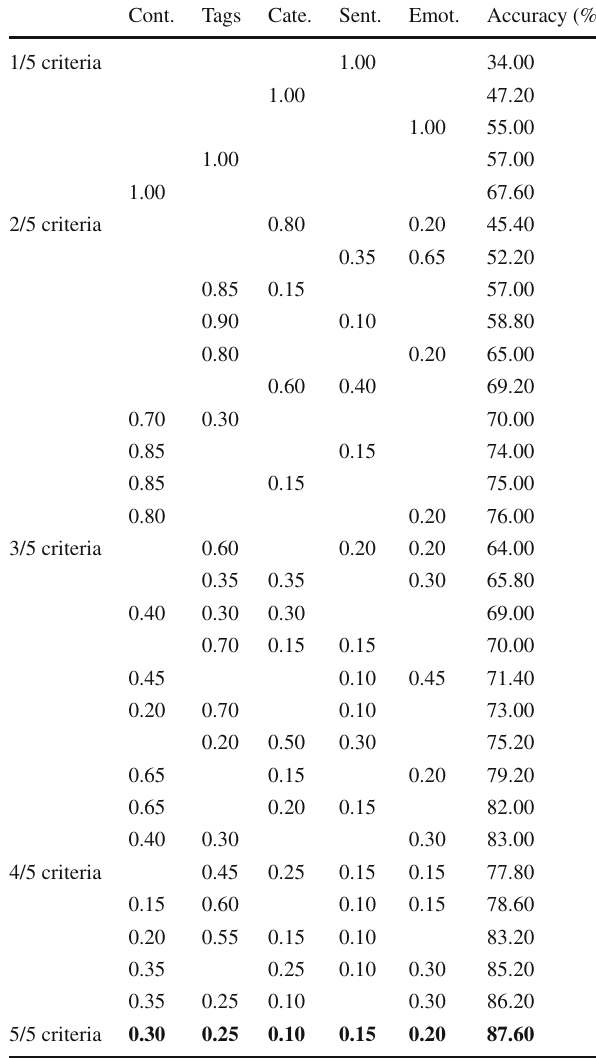
Table 4 Best weight of the entry criteria for the sample set Cont. Tags Cate. Sent.